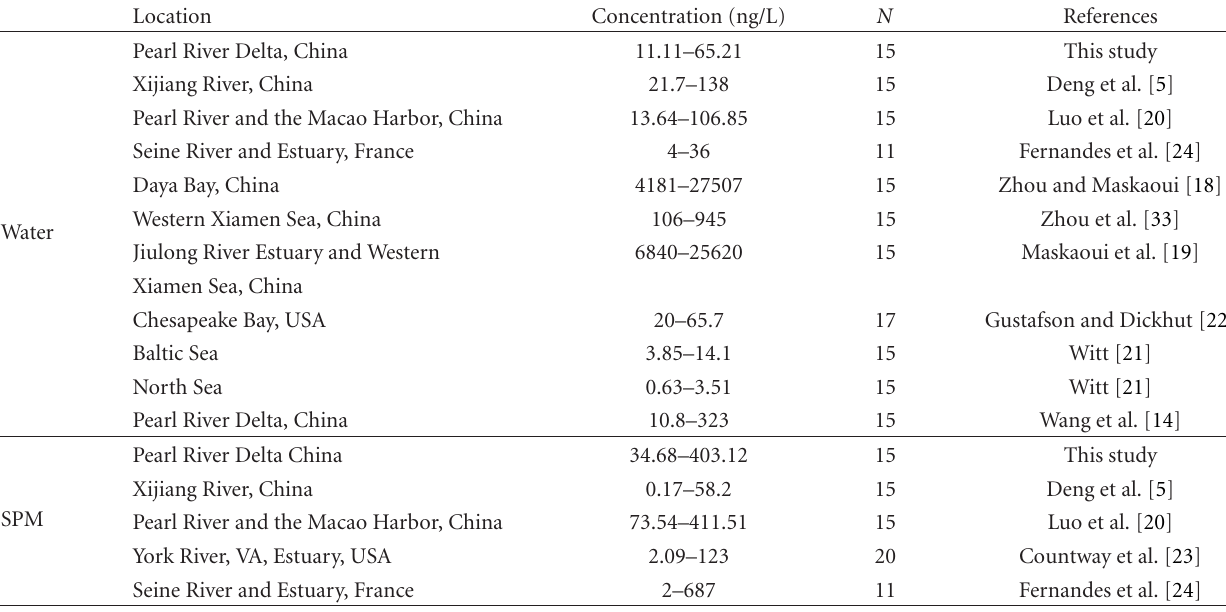
Table 3: Summary of total PAHs concentration (ng/L) in water and SPM from di ff erent sites around the